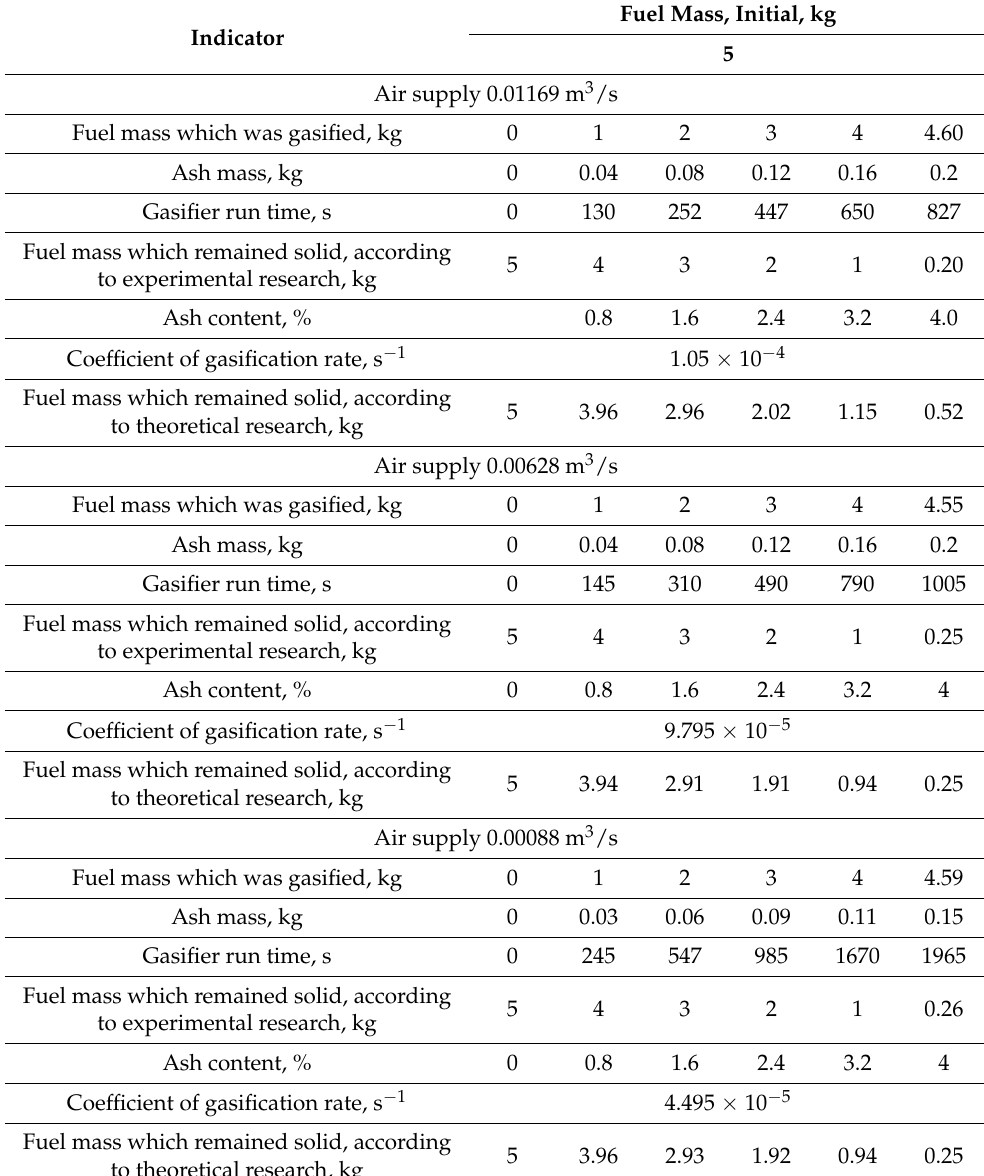
Table 2. Indicators of experimental and theoretical studies of the rate of straw pellet gasification.